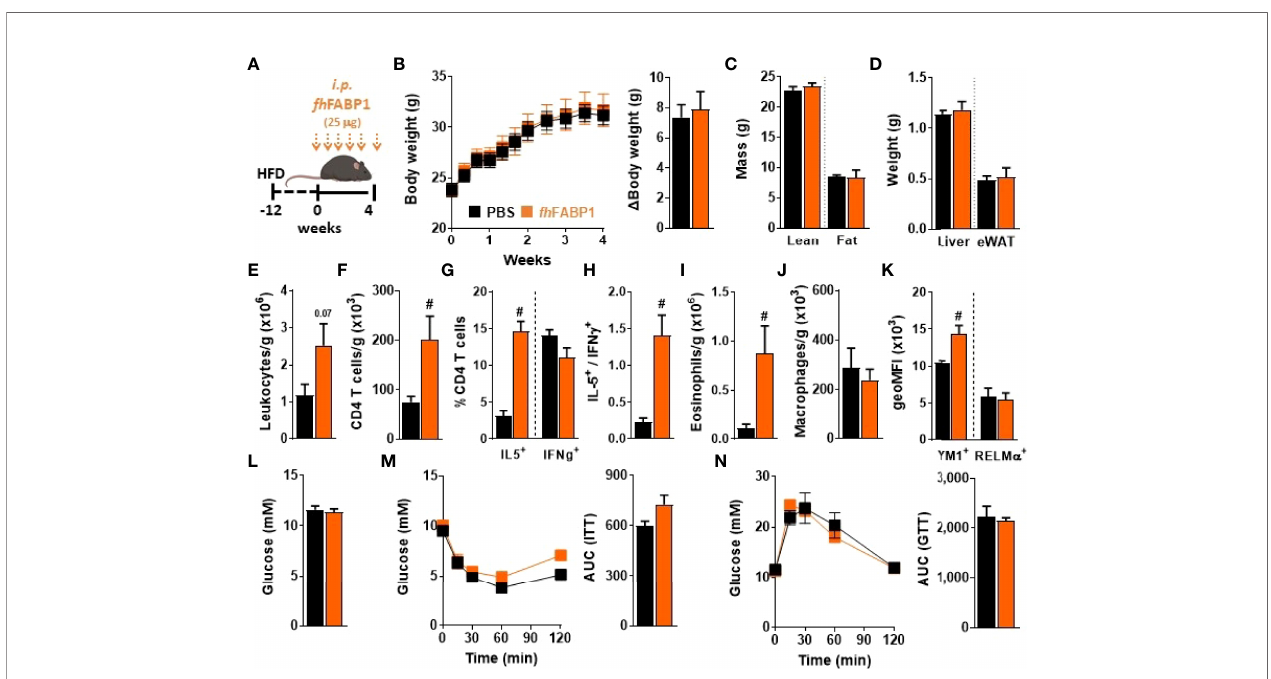
FIGURE 8 | Fasciola hepatica FABP1 induces a type 2 immune response in adipose tissue but without affecting metabolic homeostasis in obese mice Mice were fed a high-fat diet (HFD) for a period of 12 weeks and then received intraperitoneal injections of 25 µg recombinant fh FABP1 (orange squares/bars) or vehicle (PBS, black squares/bars) every 3 days for 4 weeks (A) Body weight was monitored throughout the supplementation period (B) At week 4, body composition was determined (C) After sacri fi ce, the weights of the liver and eWAT were measured (D) The number of eWAT total leukocytes (E), CD4 + T cells (F) , eosinophils (I) and total macrophages (J) , together with the percentage of CD44 + , IL-5 + , IFN g + CD4 + T cells (G) and the YM1 and RELM a mean expression on macrophages (K) were determined by fl ow cytometry The IL-5 + -on-IFN g + ratio was calculated (H) At week 4, fasting blood glucose levels were measured (L) At week 3-4, whole-body insulin sensitivity (M) and glucose tolerance (N) were performed and the respective AUC was calculated Results are expressed as mean ± SEM # P ≤ 005 vs HFD (n=5-6 mice per